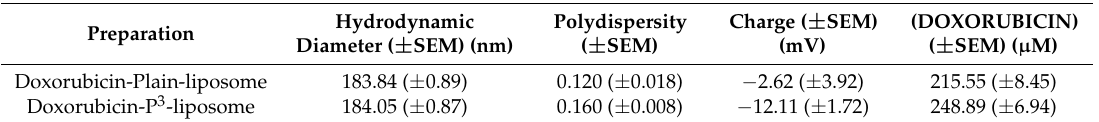
Table 2. Physicochemical properties of doxorubicin-loaded Plain-liposomes (doxorubicin-Plain-liposome) and doxorubicin-loaded P 3 -liposomes (doxorubicin-P 3 -liposome).